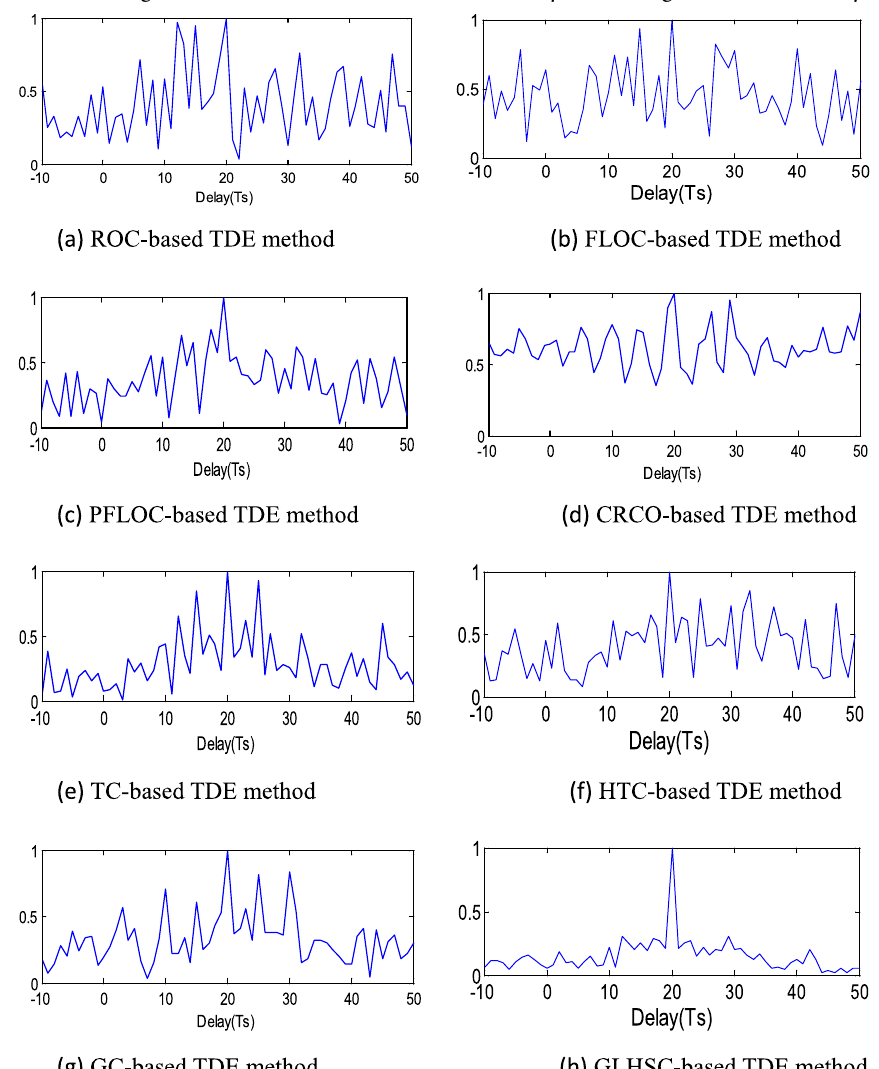
Fig. 4 The single estimation results of the eight methods in S α S distribution noise ( GSNR = 0dB and α =